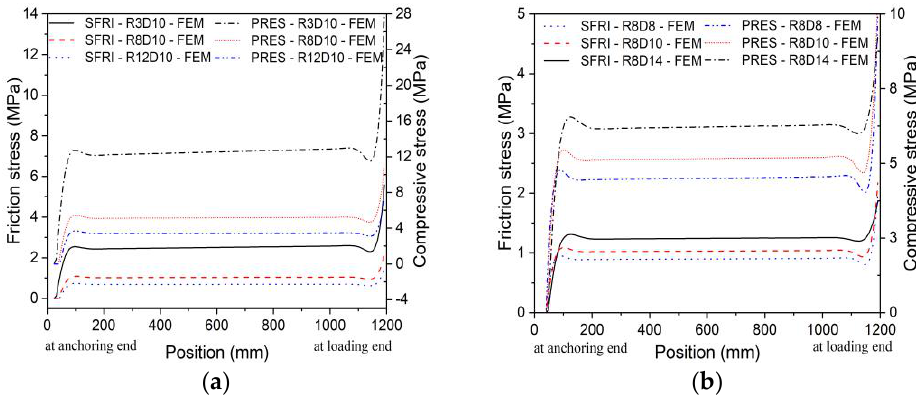
Figure 12. Friction stress and contact compressive stress distributions of CFRP tendons: ( a ) D10; ( b ) R8. ( b )